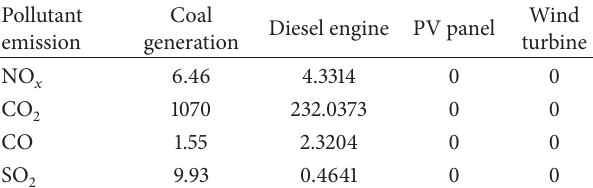
Table 1: The pollutant emission rate of DG units (g/kWh). Pollutant